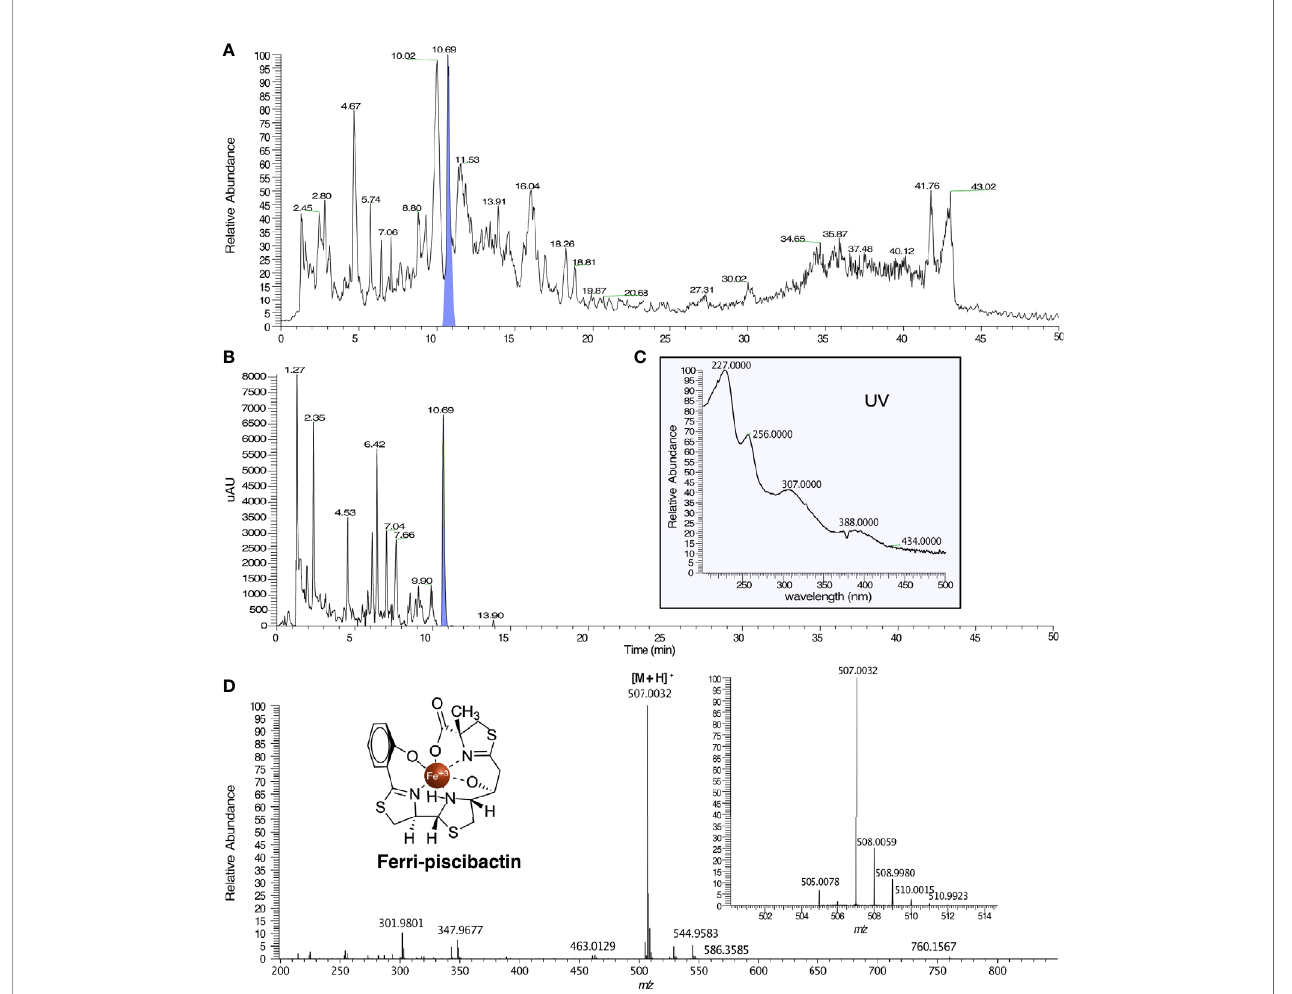
FIGURE 5 | HPLC/HRMS analysis for the detection of ferri-piscibactin in the fraction VN D absFH3, from the V. neptunius D absF mutant, eluted with 1:1 H 2 O:ACN from a HLB cartridge. (A) Total Ion Current (TIC) chromatogram of VN D absFH3 in which ferri-piscibactin was detected at R t = 10.69 min, highlighted in blue. (B) HPLC-DAD chromatogram of VN D absFH3 in which ferri-piscibactin was detected at R t = 10.69 min, highlighted in blue. (C) UV spectrum of the peak at R t = 10.69 min, where ferri-piscibactin was detected, showing the absorption maxima at 207, 256, 307 and 388 nm. (D) (+)-HRESIMS of the peak at R t 10.69 min, where ferri-piscibactin was identi fi ed, displaying: m/z 507.0032 (calcd. for C 19 H 21 N 3 O 4 S 3 Fe + , m/z 507.0038), expanded region of MS in the range m/z 501-514, showing the presence of the characteristic Fe isotopic distribution, and structure of